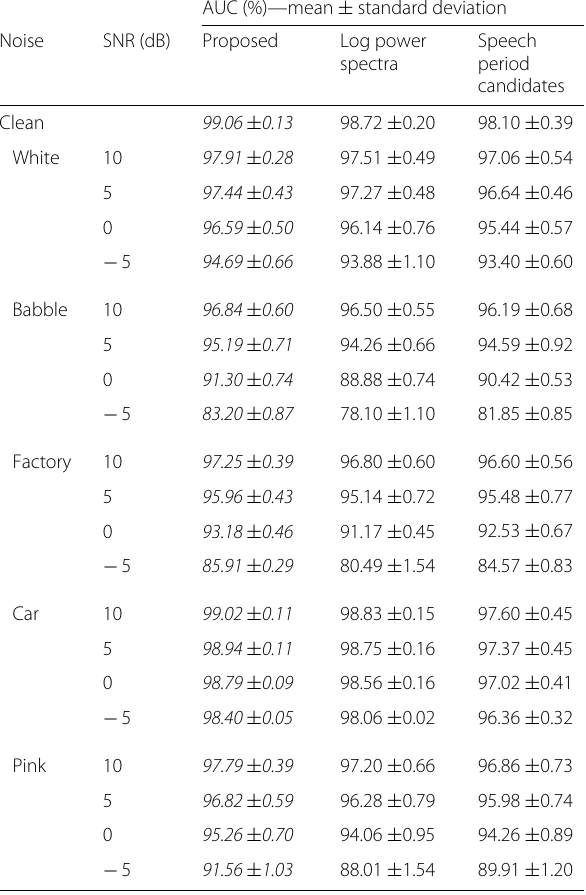
Table 1 AUC (%) comparison between the proposed method and DNN-based VAD methods using speech period candidates and log power spectra as the